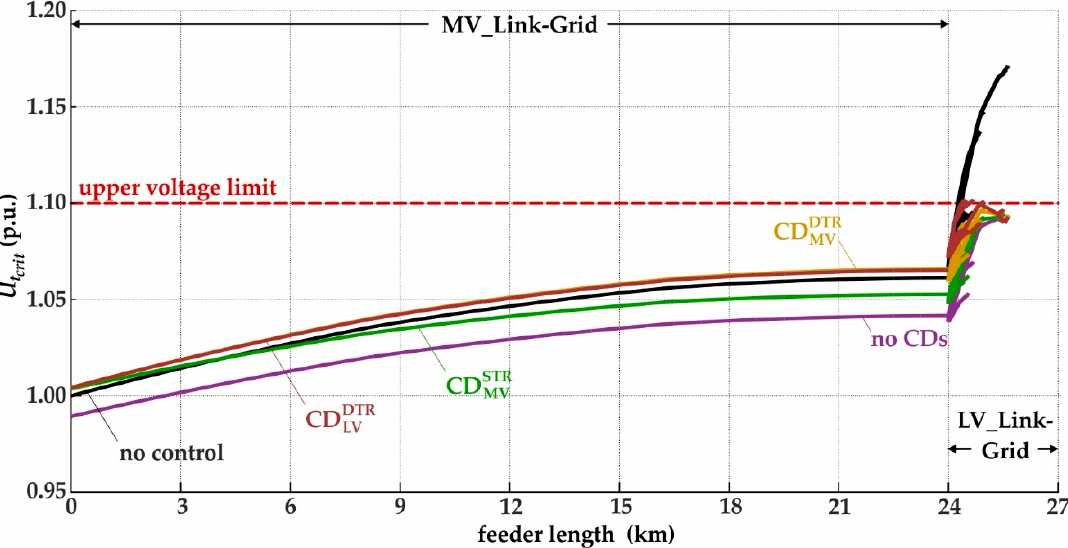
Figure 10. Voltage profile of the MV_link-grid with cable conductors and the backmost LV_link-grid at t = t crit .